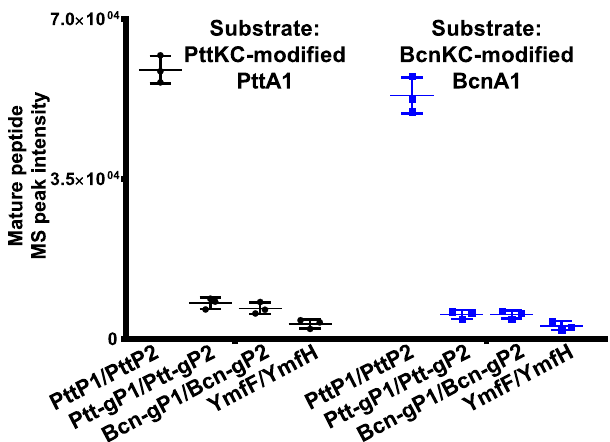
Fig. 5 Different ef fi ciencies of Prot_819/Prot_176 members. PttP1/PttP2, Ptt-gP1/Ptt-gP2, Bcn-gP1/Bcn-gP2, and YmfF/YmfH against PttKC- modi fi ed PttA1 and BcnKC-modi fi ed BcnA1, respectively, with PttP1/ PttP2 showing the highest ef fi ciency in both cases. Error bars indicate standard deviation across triplicates. Data shown as mean ± SD (each group n = 3; SD: standard